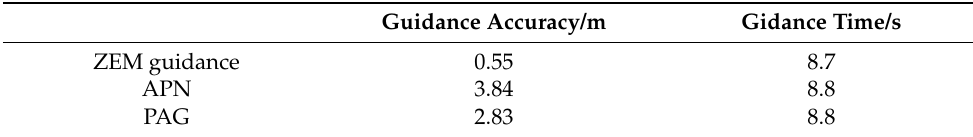
Table 2. Performances of different guidances with constant